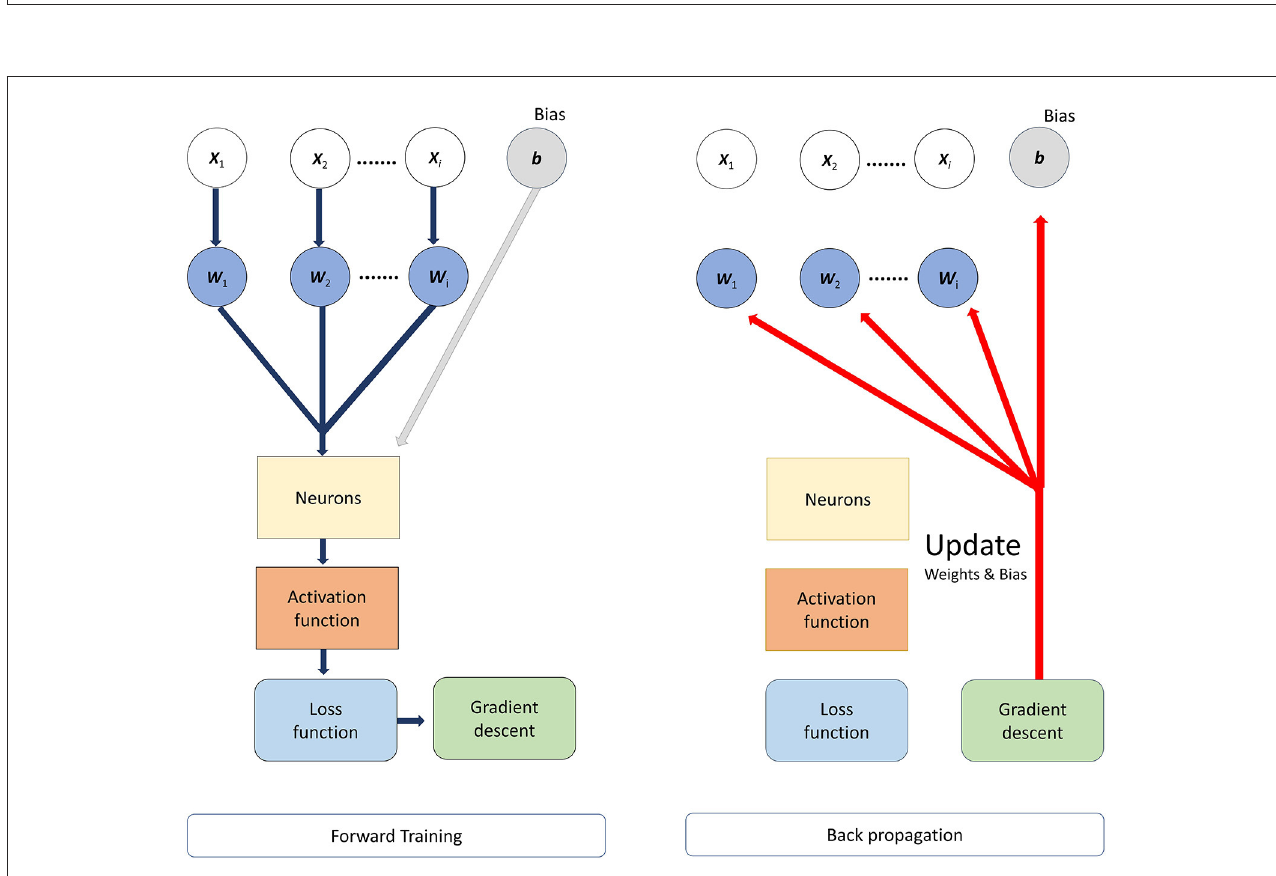
FIGURE2 The workflow of backward propagation neural network